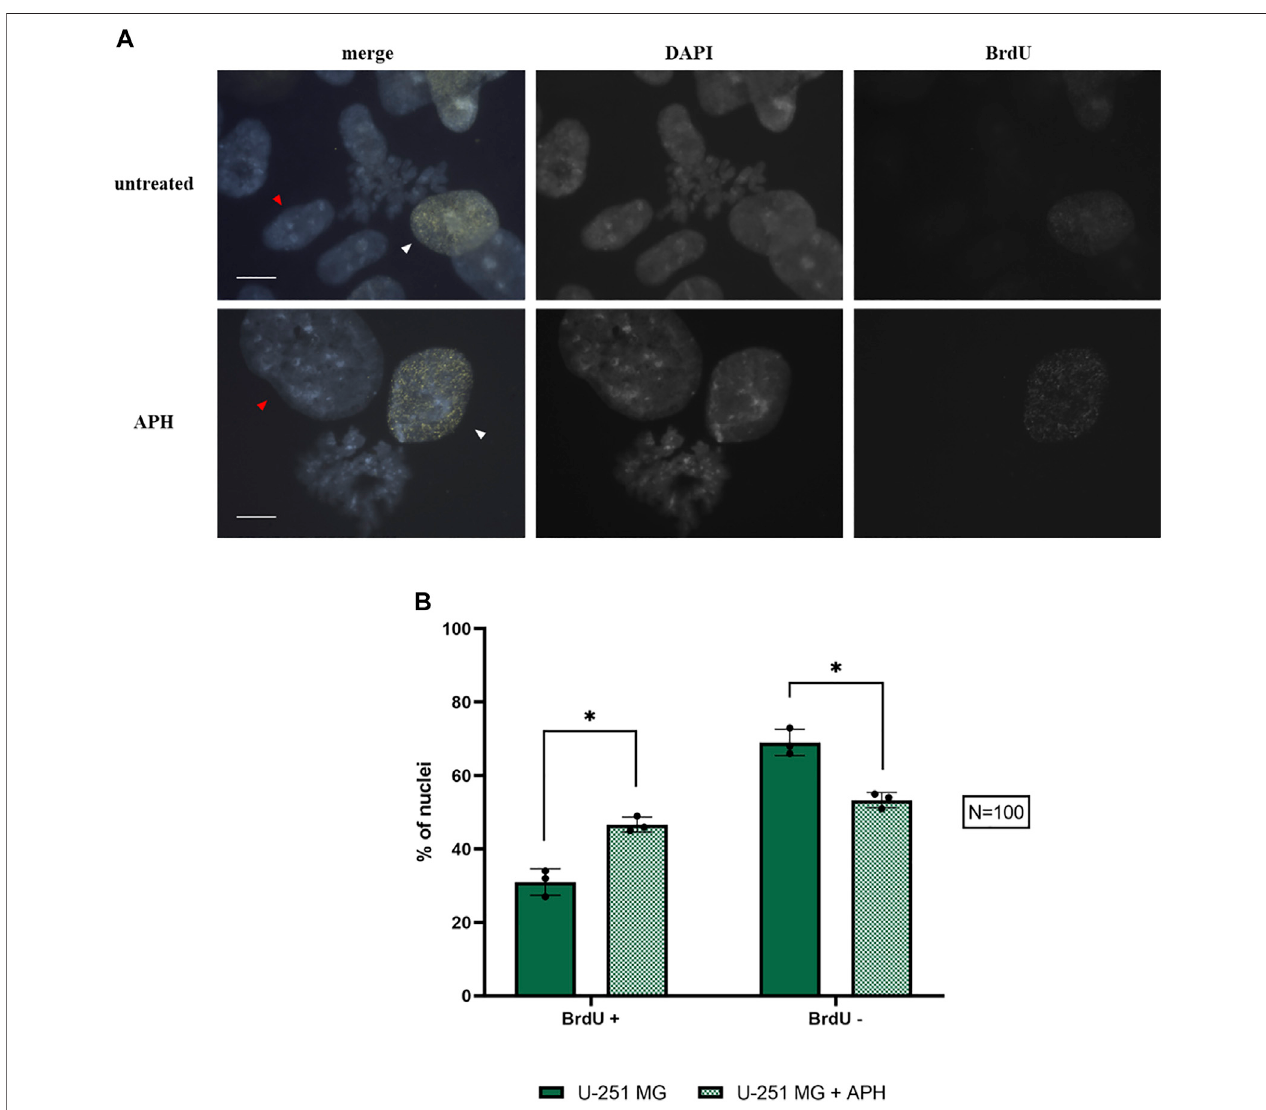
FIGURE 8 | Replicating nuclei under control and APH-treated conditions with BrdU foci (yellow) and DAPI staining (blue) (A) ; the graph indicates the amount of BrdU-negative (non-replicating cells, red arrows) and BrdU-positive (replicating cells, white arrows) glioblastoma cells under control and APH-treated conditions (B) . Scale bar: 10 µm. The error bars represent standard deviation (SD) determined from 3 independent experiments ( N (cid:1) 100 nuclei for each replicate). Paired t -test was used to calculate the p values, where p > 0.05 ns, * p ≤ 0.05, ** p < 0.01, *** p < 0.001, and **** p < 0.0001.